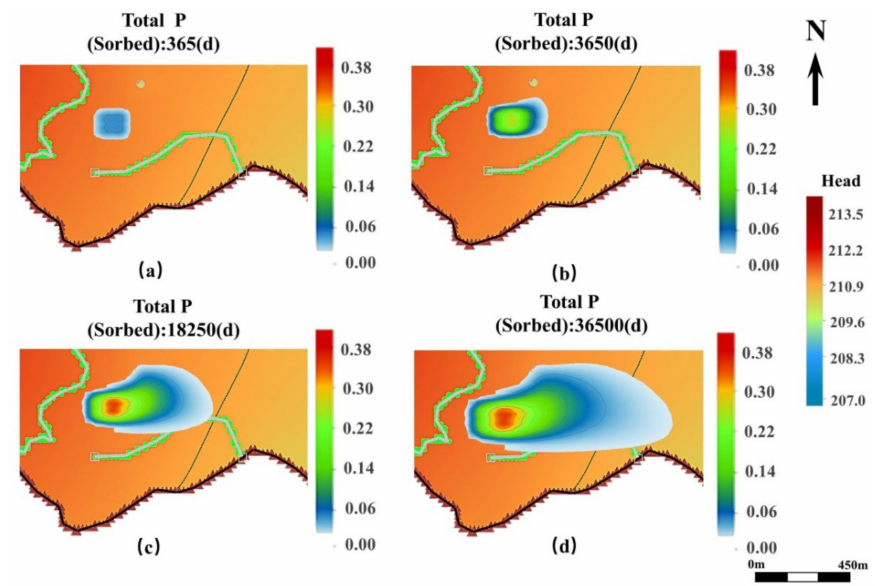
Figure 7. MT3DMS simulation results of the horizontal TP transport in the western part of the study area. ( a – d ) shows the transport of TP after 1 year, 10 years, 50 years, and 100 years of groundwater dispersion, respectively.